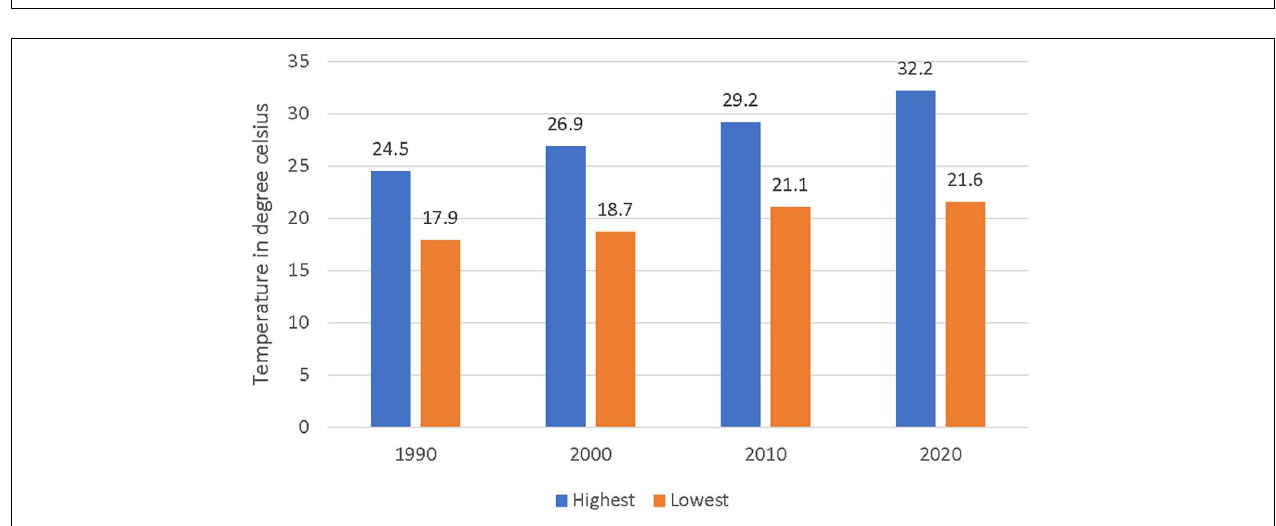
FIGURE 5 | Land surface temperature ( ◦ C) upward trend in each decade at DDWS.